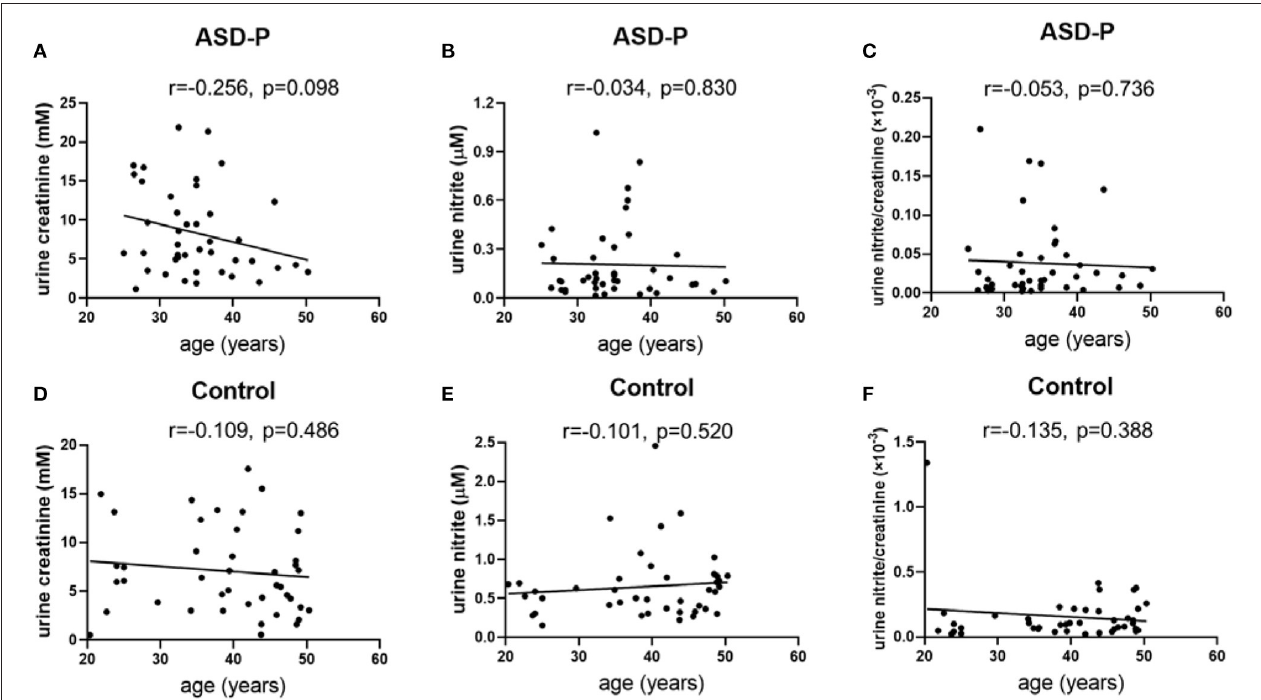
FIGURE 2 | Examination of urine creatinine, nitrite and nitrite/creatinine vs. age. (A) urine creatinine and age in the ASD-P group, p = 0.098. (B) urine nitrite and age in the ASD-P group, p = 0.830. (C) urine nitrite/creatinine and age in the ASD-P group, p = 0.736. (D) urine creatinine and age in the Control group, p = 0.486. (E) urine nitrite and age in the Control group, p = 0.520. (F) urine nitrite/creatinine and age in the Control group, p = 0.388.